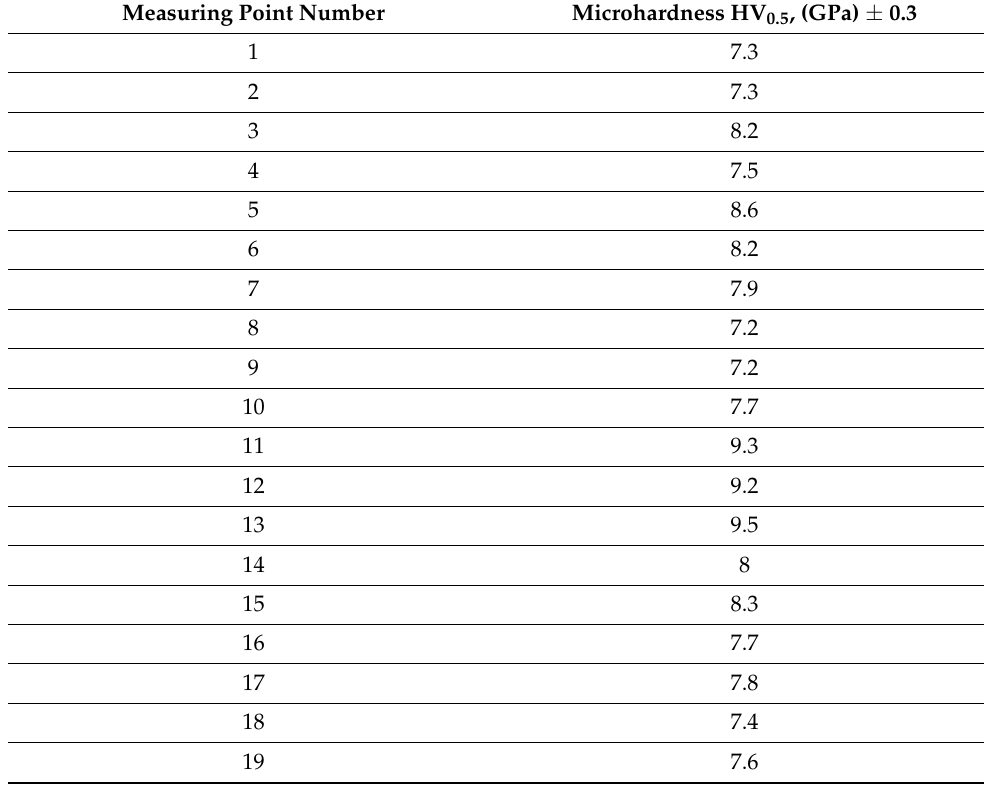
Figure 4. Schematic diagram of the microhardness measuring process in the selected material region ( a ), microhardness measuring results ( b ). Table 2. Results of measuring the microhardness of NiTi-TiB 2 composite materials obtained by high-temperature vacuum sintering.